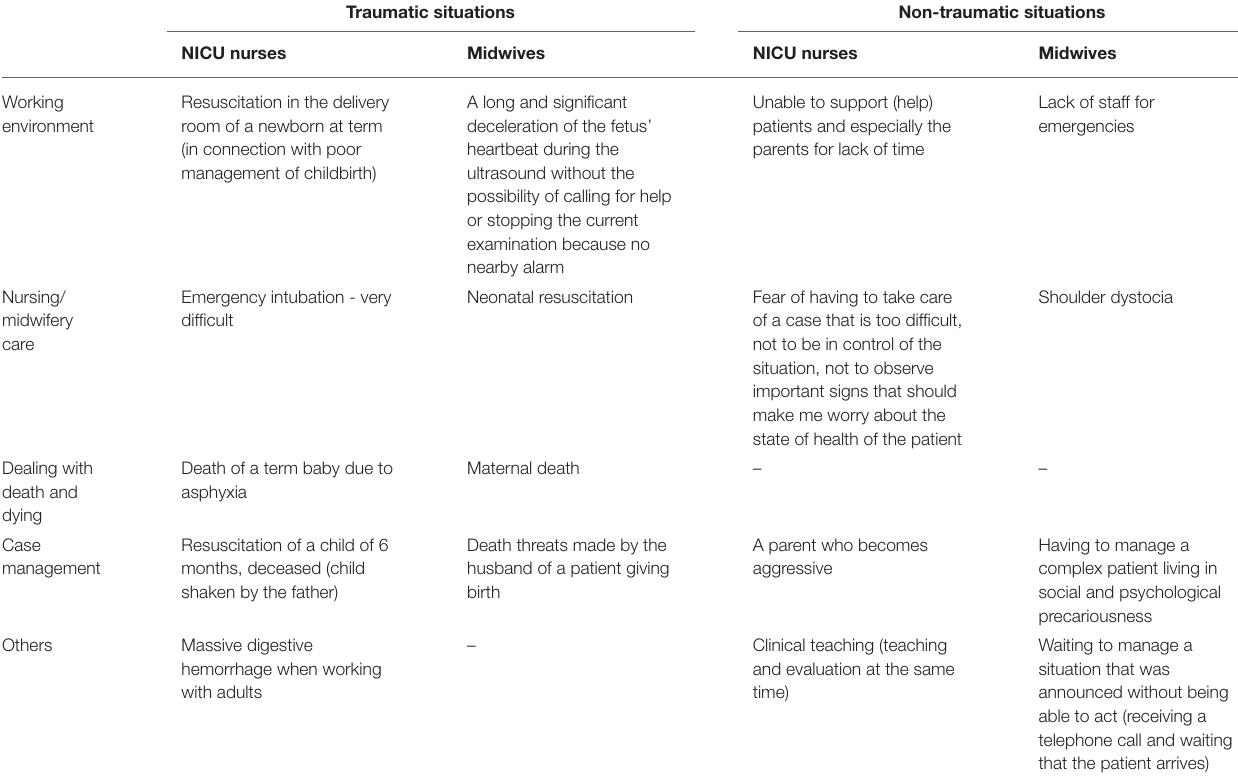
TABLE 5 | Examples of traumatic and non-traumatic work-related